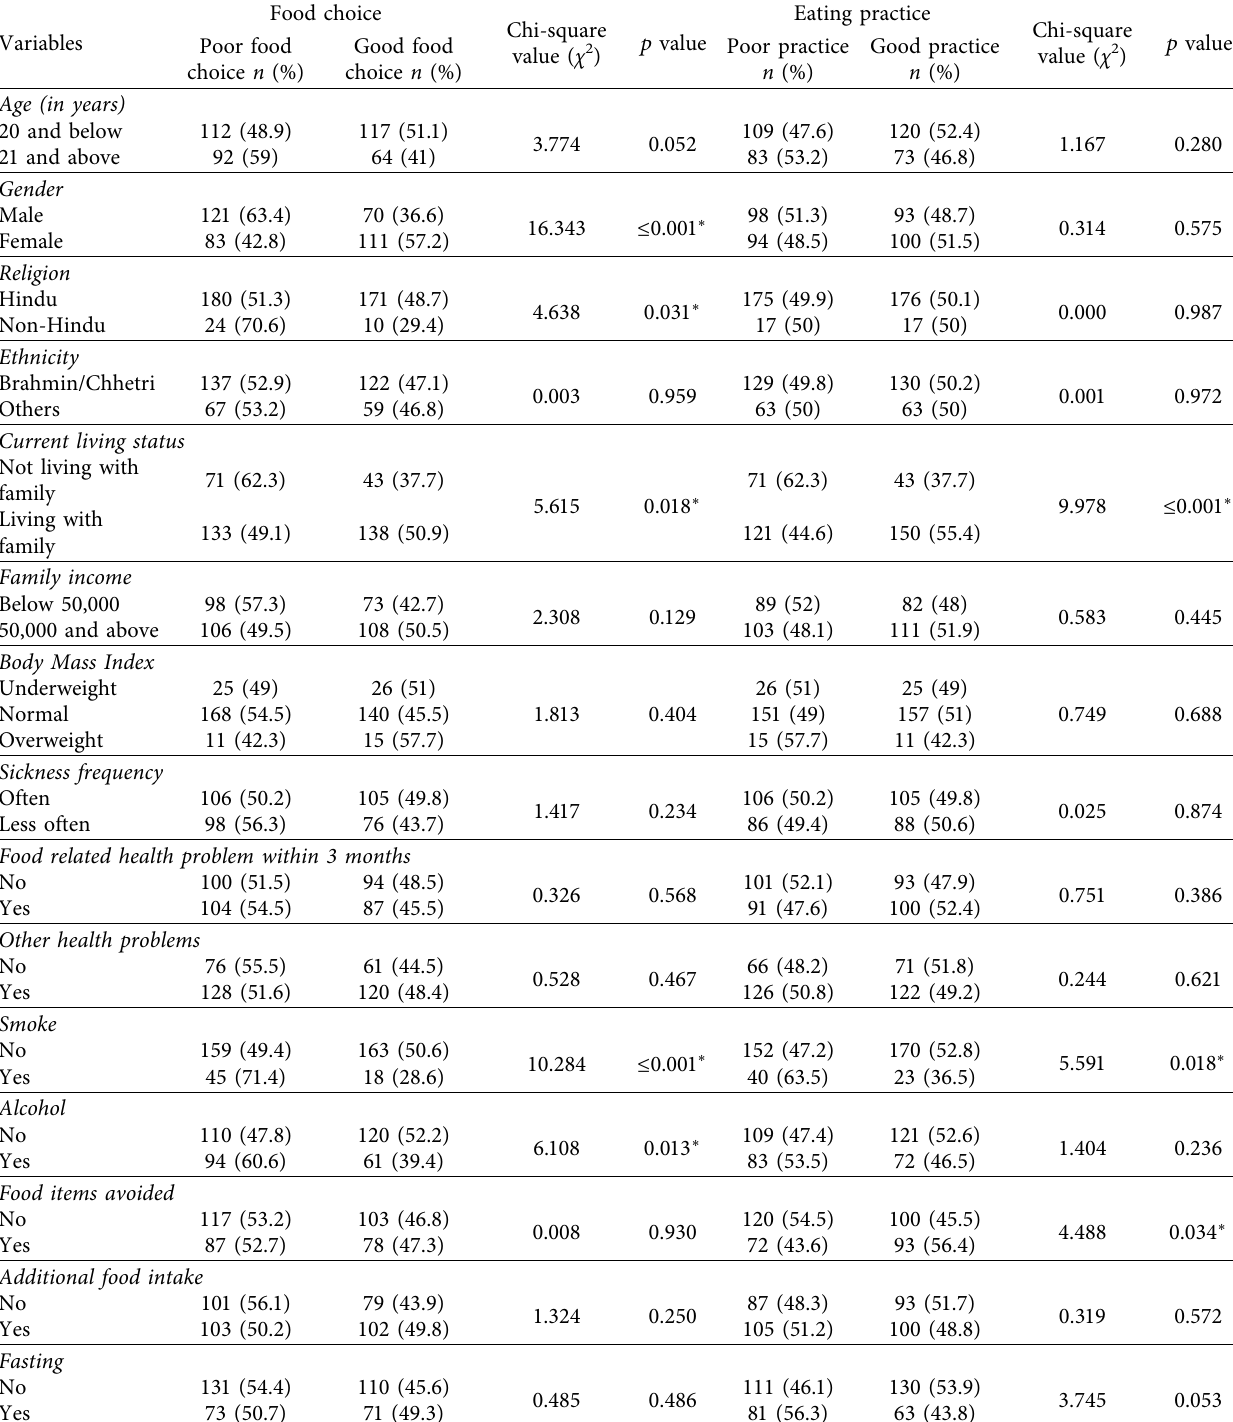
Table 4: Association between food choice and eating practice with sociodemographic characteristics, health status, and behavioural factors of the